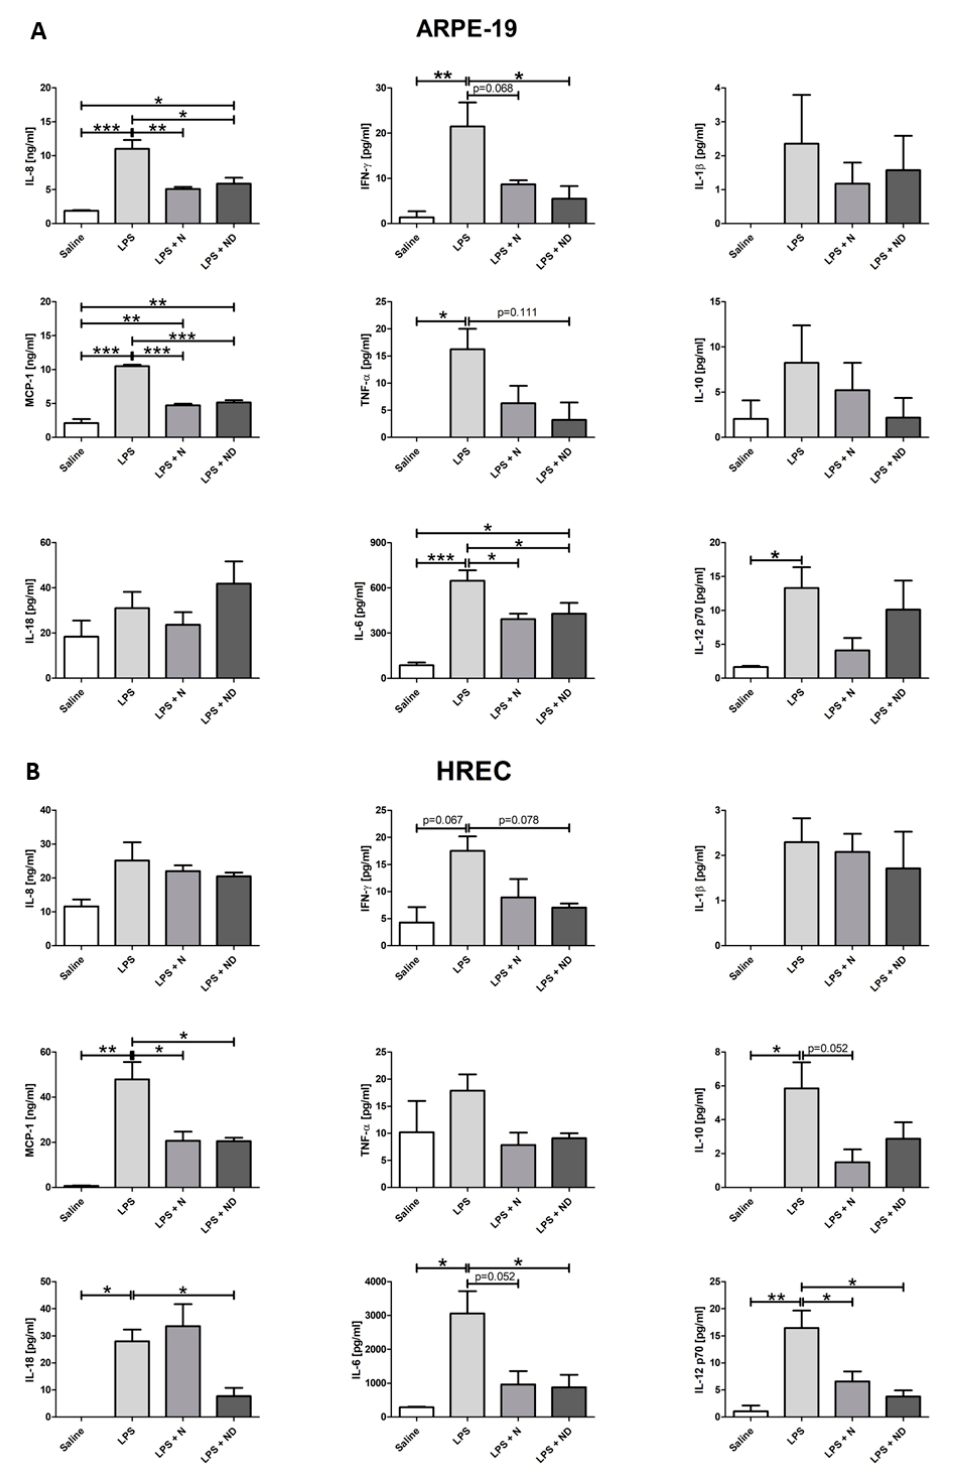
Figure 4. Multiple cytokine expression assays in ARPE-19 and HREC cells ( n = 3 ) . ( A ) Expression levels of IL-8, MCP-1, TNF- α , IFN γ , IL-6, and IL-12p70 were significantly increased ( p < 0.05) following addition of LPS (24 h; 20µg/mL) to induce inflammatory-like conditions in ARPE cells. IL-8, MCP-1, and IL-6 expression levels were significantly reduced ( p < 0.05) following application of N and ND (62.34µg/mL each) during the last hour of the induction time. Addition of ND in LPS-induced media was able to significantly decrease ( p < 0.05) the expression levels of IFN γ and attenuate the expression of